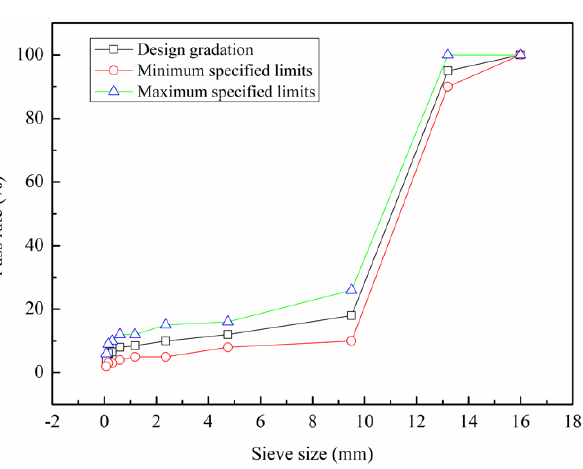
Figure 1. Gradation curve for base asphalt mixture.